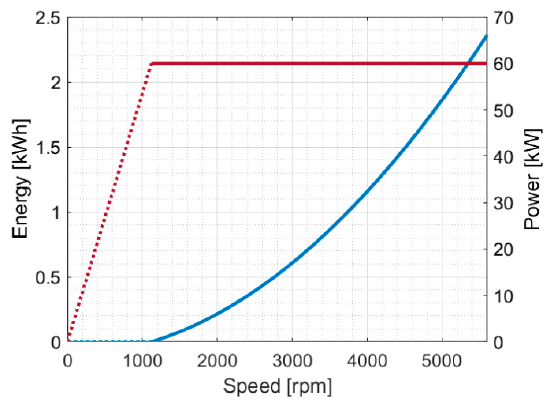
Figure 6. OBOLAR-FLY SR machine case study: rated power (red) and energy (blue) vs. speed characteristics.